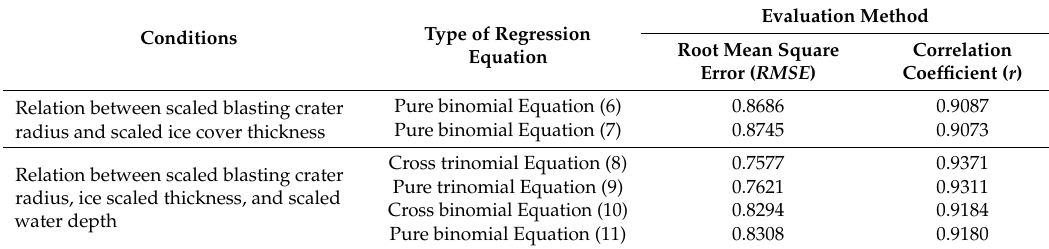
Table 2. Evaluation of predicted and experimental results using different regression methods.